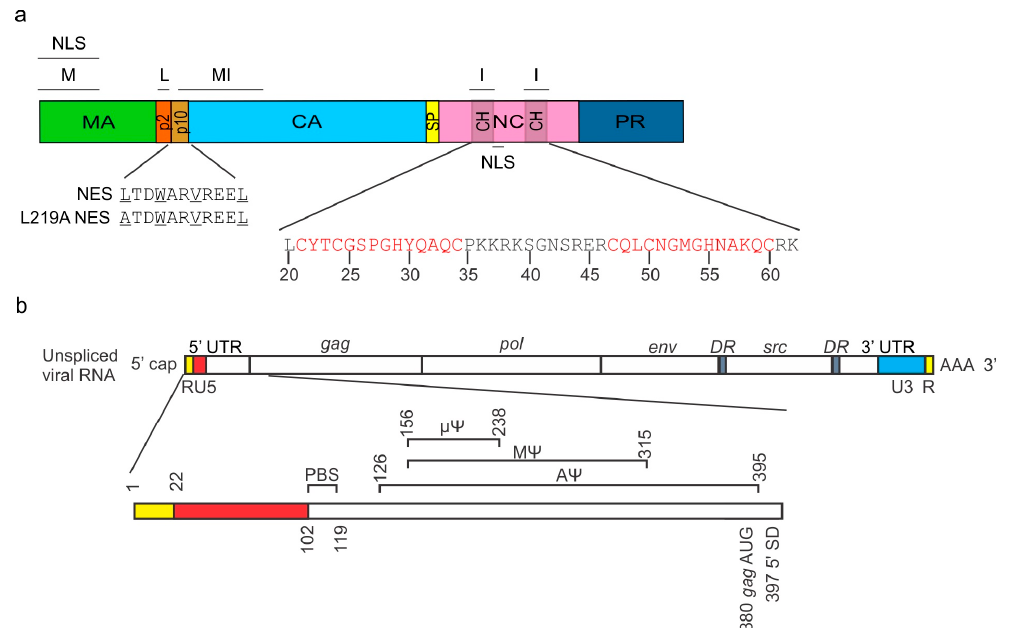
Figure 1. The Rous sarcoma virus (RSV) Gag polyprotein domain organization and functional sequences in the 5 ′ untranslated region (UTR) of the genomic RNA. ( a ) The RSV Gag protein is made of multiple domains: matrix (MA; green) contains the membrane binding motif (M) and a non-canonical nuclear localization signal (NLS); p2 (orange) contains the late (L) motif. p10 (gold) contains a chromosome region maintenance 1 (CRM1)-dependent nuclear export signal (NES); capsid (CA; blue) contains a multimerization interface (MI) that extends from p10; spacer peptide (SP; yellow); nucleocapsid (NC; pink) binds nucleic acids and proteins via interaction motifs (I) and Cys-His boxes (CH; translucent grey) and also contains an NLS; and protease (PR; blue). The Cys-His boxes contain zinc finger domains (red) required for the binding of the Ψ packaging sequence located in the 5 ′ UTR of the viral RNA (vRNA); ( b ) The primer binding site (PBS) is required for reverse transcription (nts 102–119). The entire RSV packaging sequence A Ψ extends from nucleotides 126–395. The M Ψ sequence extends from nucleotides 156–215. The minimal functional packaging element, identified as µ Ψ , is 82 nucleotides in length, extending from 156 to 238. Because the splice donor (SD) is located downstream of the packaging sequence at nucleotide 397, the Ψ sequence is contained in both spliced and unspliced vRNAs. DR: direct repeat; RU5: repeat-unique 5’; U3: unique 3’.